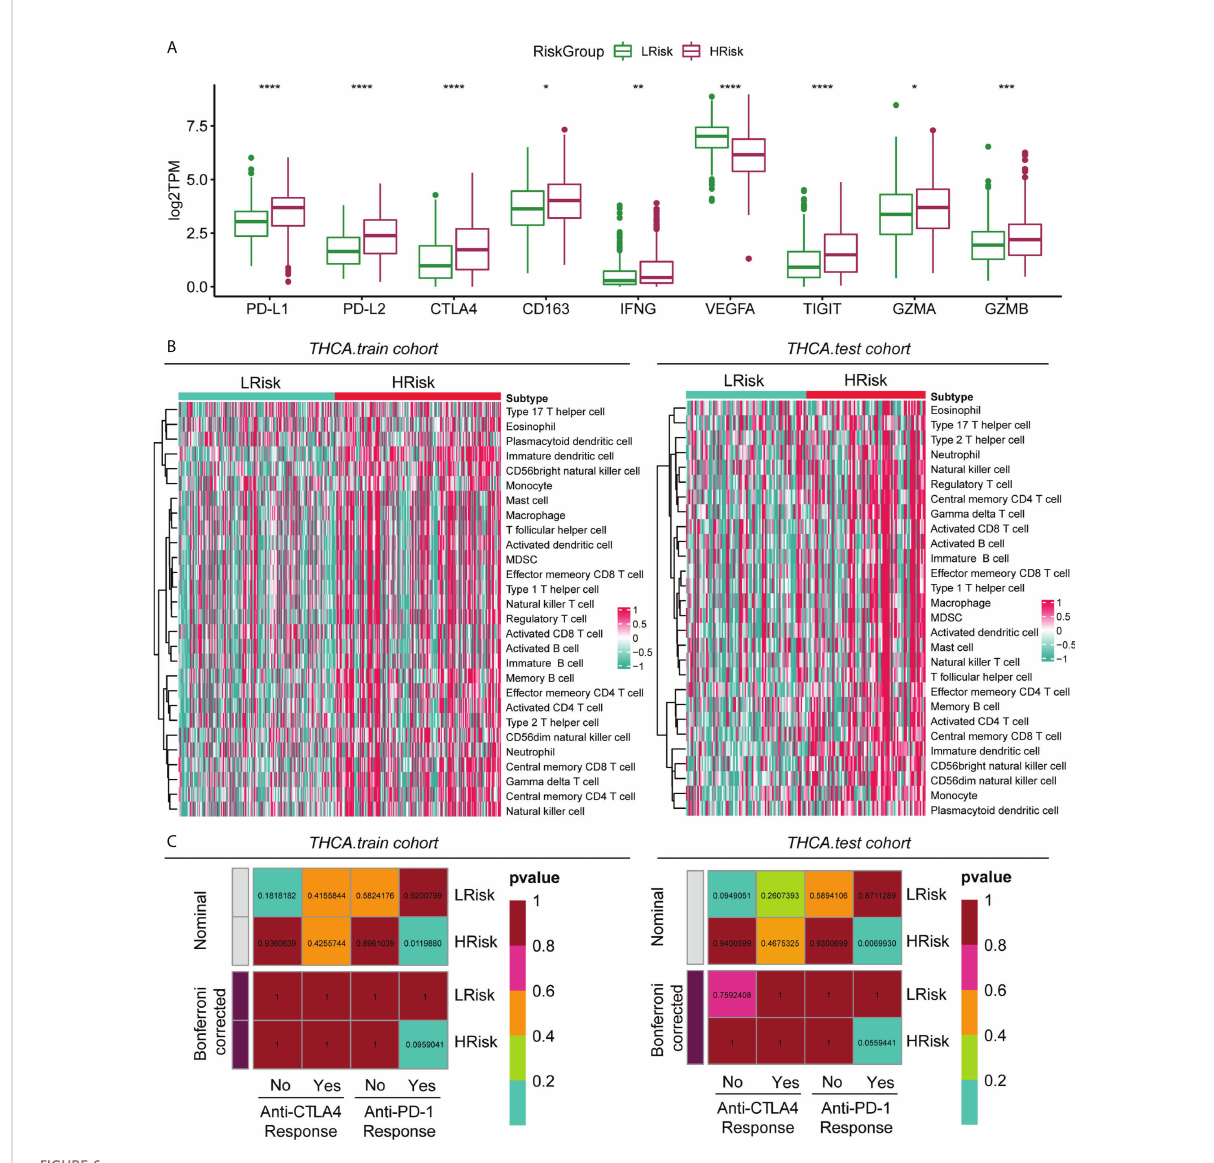
FIGURE 6 Immune characteristics of different groups in the metadataset. (A) Expression level (normalized count) of 9 immune checkpoint genes in the HRisk and LRisk groups. The signi fi cant difference was compared through the Kruskal – Wallis test, and the P values are labelled above each boxplot with asterisks (ns represents no signi fi cance, *P < 0.05, **P < 0.01, ***P < 0.001, ****P < 0.0001). (B) Heatmap describing the abundance of immune and stromal cell populations in the HRisk and LRisk groups. (C) Prediction results of the response to anti-CTLA-4 and anti-PD-1 therapy in the HRisk and LRisk groups by subclass mapping